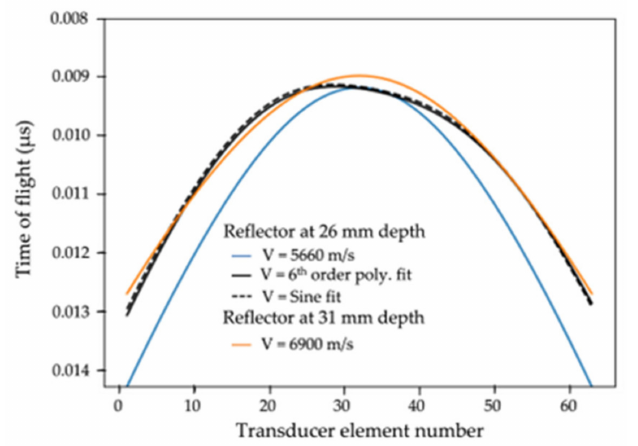
Figure 8. Variations in calculated time of flight values for 64 elements configurations working in pulse-echo